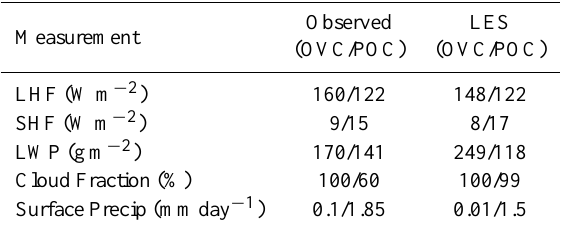
Table 2. Comparison of a variety of observed OVC and POC mean values with LES output sampled from the respective model regions during the two-hour period (model time 02:00–04:00LST) used for LES